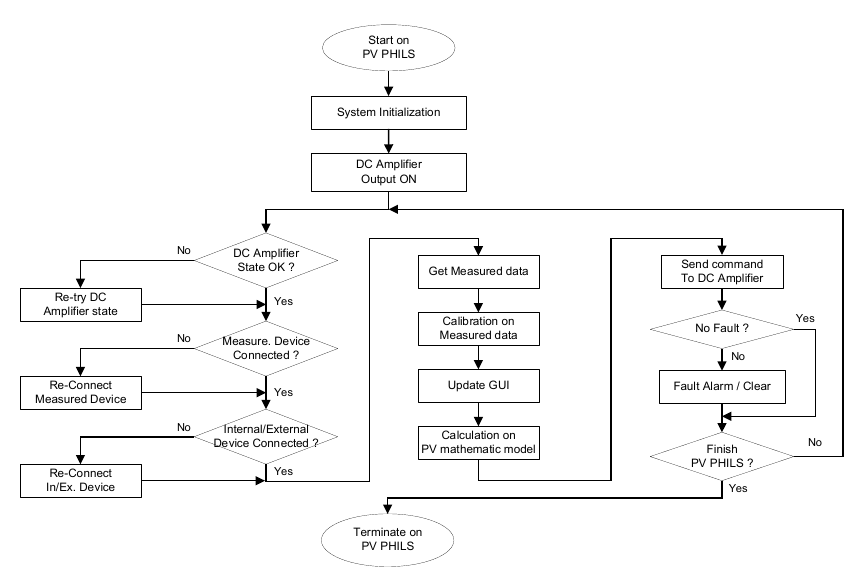
Figure 8. Centralized control logic of the proposed PV PHIL simulator.